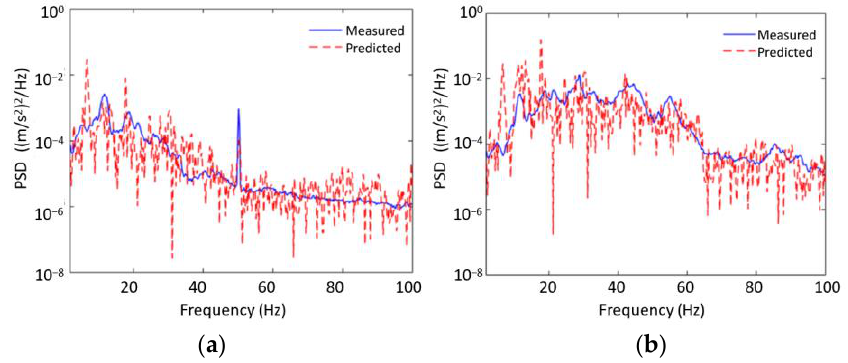
Figure 12. Power spectral density of seat acceleration in Z- direction. ( a ) 350 km/h; ( b ) 250 km/h.